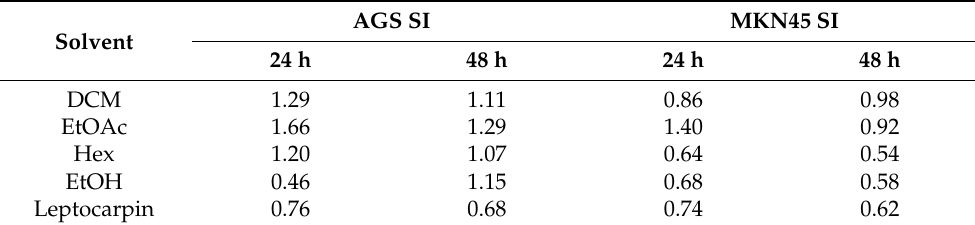
Table 4. Selectivity index (SI) for L. rivularis flower extracts in AGS and MKN45 gastric cancer cells. The selectivity index is the ratio of the IC 50 values of the treatments on GES-1 cells to those in the gastric cancer cell